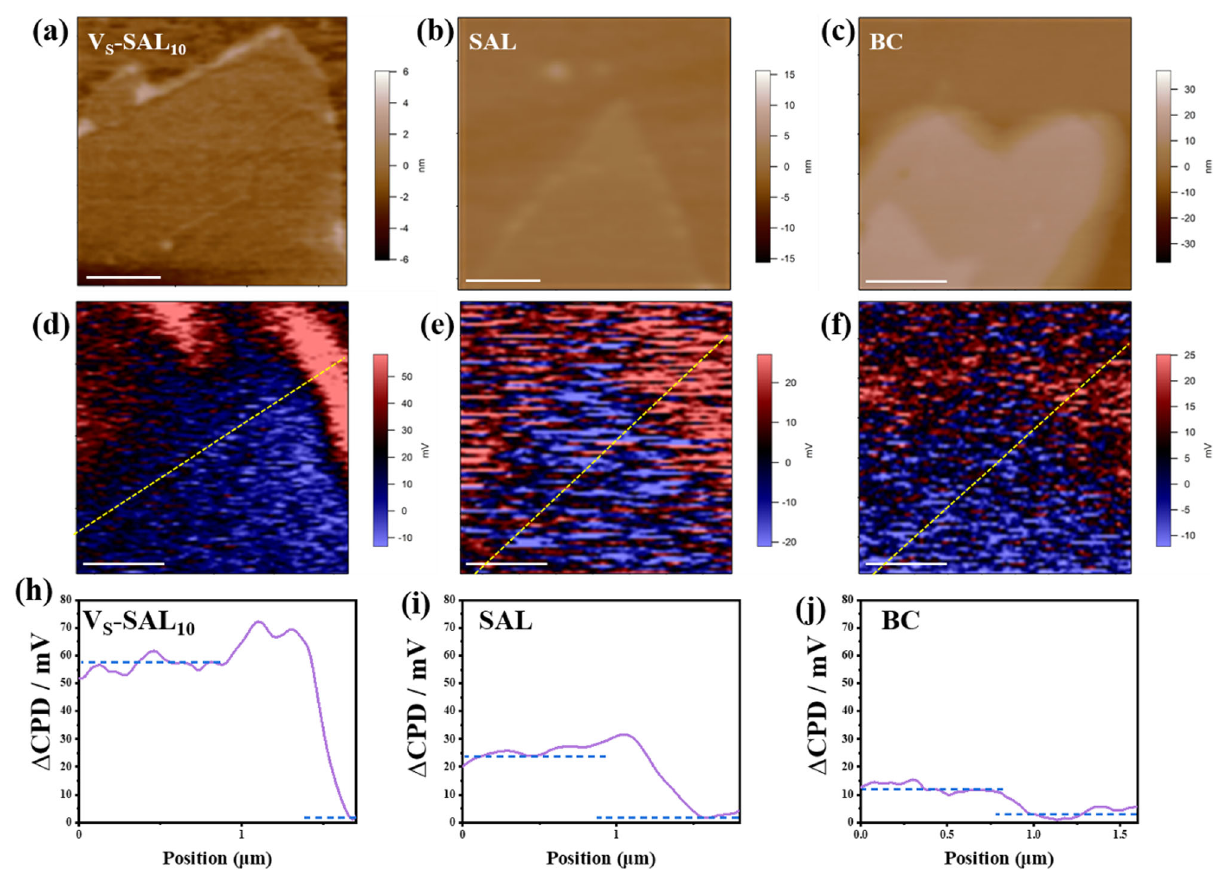
Fig. 5 SPV characterization. Height images of a V S -SAL 10 , b SAL, and c BC. The SPV images d V S -SAL 10 , e SAL, and f BC in ( a – c ), respectively, are differential images between potential images under light and in the dark. All scale bars represent 0.5 μ m. The surface photovoltage change by subtracting the potential under dark conditions from that under illumination (SPV, Δ CPD = CPD dark − CPD light) of h V S -SAL 10 , i SAL, and j